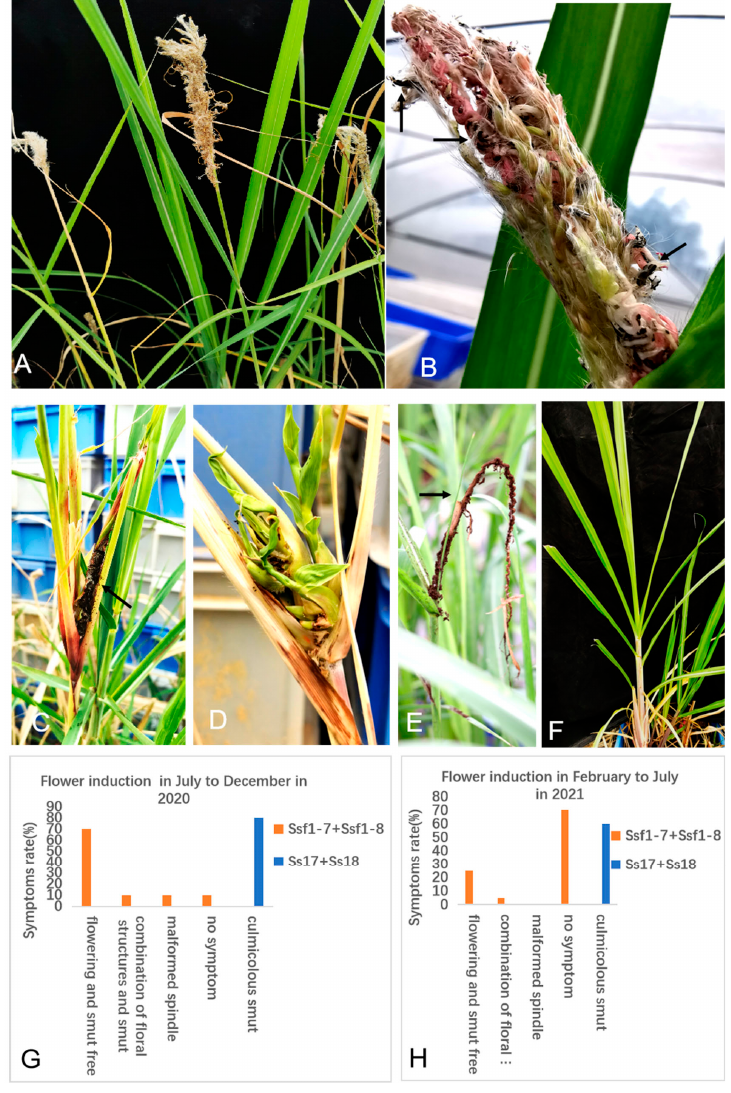
Figure 5. S. scitamineum Ssf1-7 and Ssf1-8 induced flowering in sugarcane variety (LC05-136). ( A ): Sugarcane flowering induced by inoculation with the new smut pathogen isolates of Ssf1-7 and Ssf1-8; (B): Symptom of inflorescence smut (arrows) in sugarcane infected by inoculation with the isolates of Ssf1-7 + Ssf1-8; ( C , D ): Symptom of malformed spindle in cane plant (arrow show smut); ( E ): Regular symptom of smut (arrow) in sugarcane from the top of canes induced by S. scitamineum compatible strains Ss17 and Ss18. ( F ): negative control (water inoculation); ( G ): Flower induction of sugarcane variety inoculated smut fungus mixture of Ssf1-7 + Ssf1-8 in July to December in 2020. H: Flower induction of sugarcane variety inoculated smut fungus mixture of Ssf1-7 + Ssf1-8 in the month of February to July 2021.